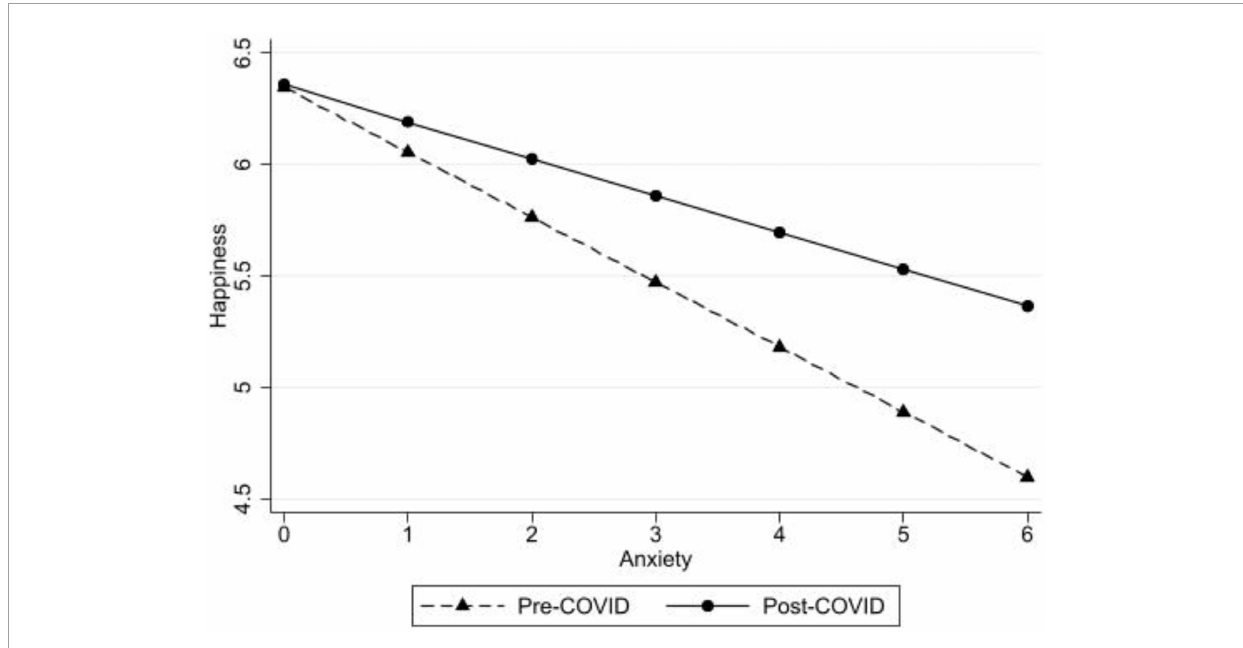
FIGURE4 Anxiety symptoms predicting happiness pre- and post- the COVID-19 pandemic declaration with the follow-up